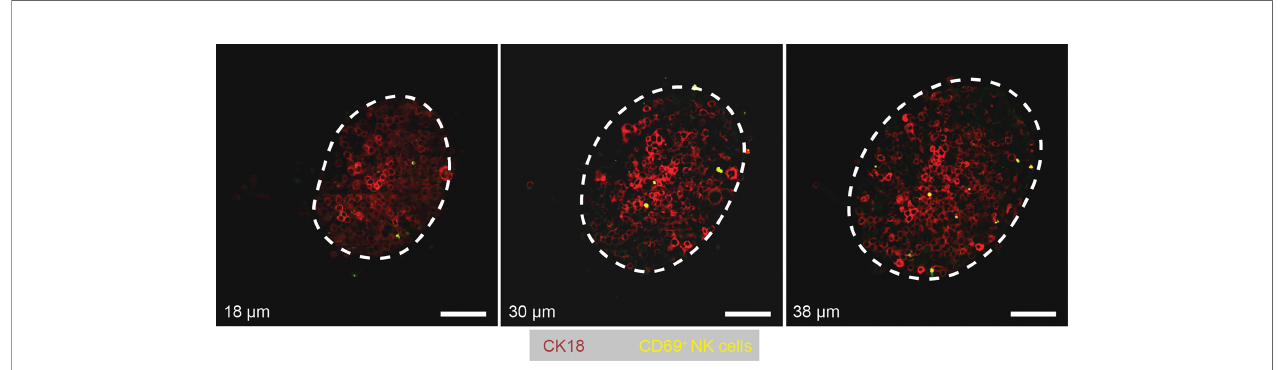
FIGURE 4 | Images showing tumor-in fi ltrating NK cells at different Z-positions in a TuMT. The Z-depth – in reference to the bottom of the TuMT – is indicated at the bottom left of each image. White dashed lines indicate the outer border of the TuMT in the corresponding Z-plane. Scale bars: 100 m m.